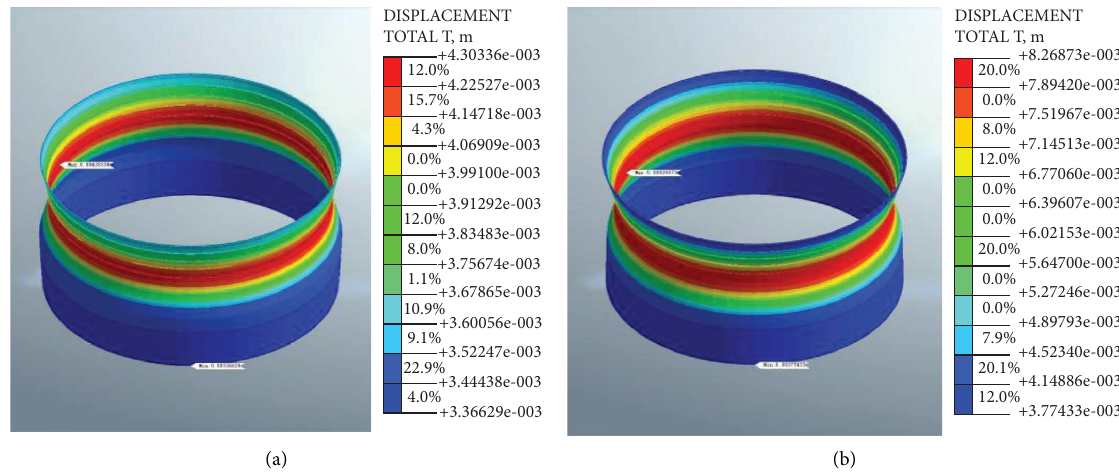
Figure 24: Working condition 6 wall deformation (a) without pore water pressure and (b) with pore water pressure applied.